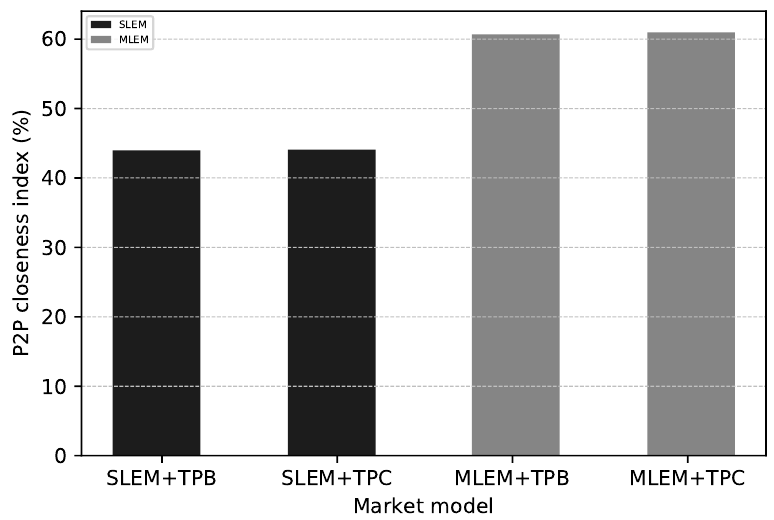
Figure 10. P2P closeness index for different market models.